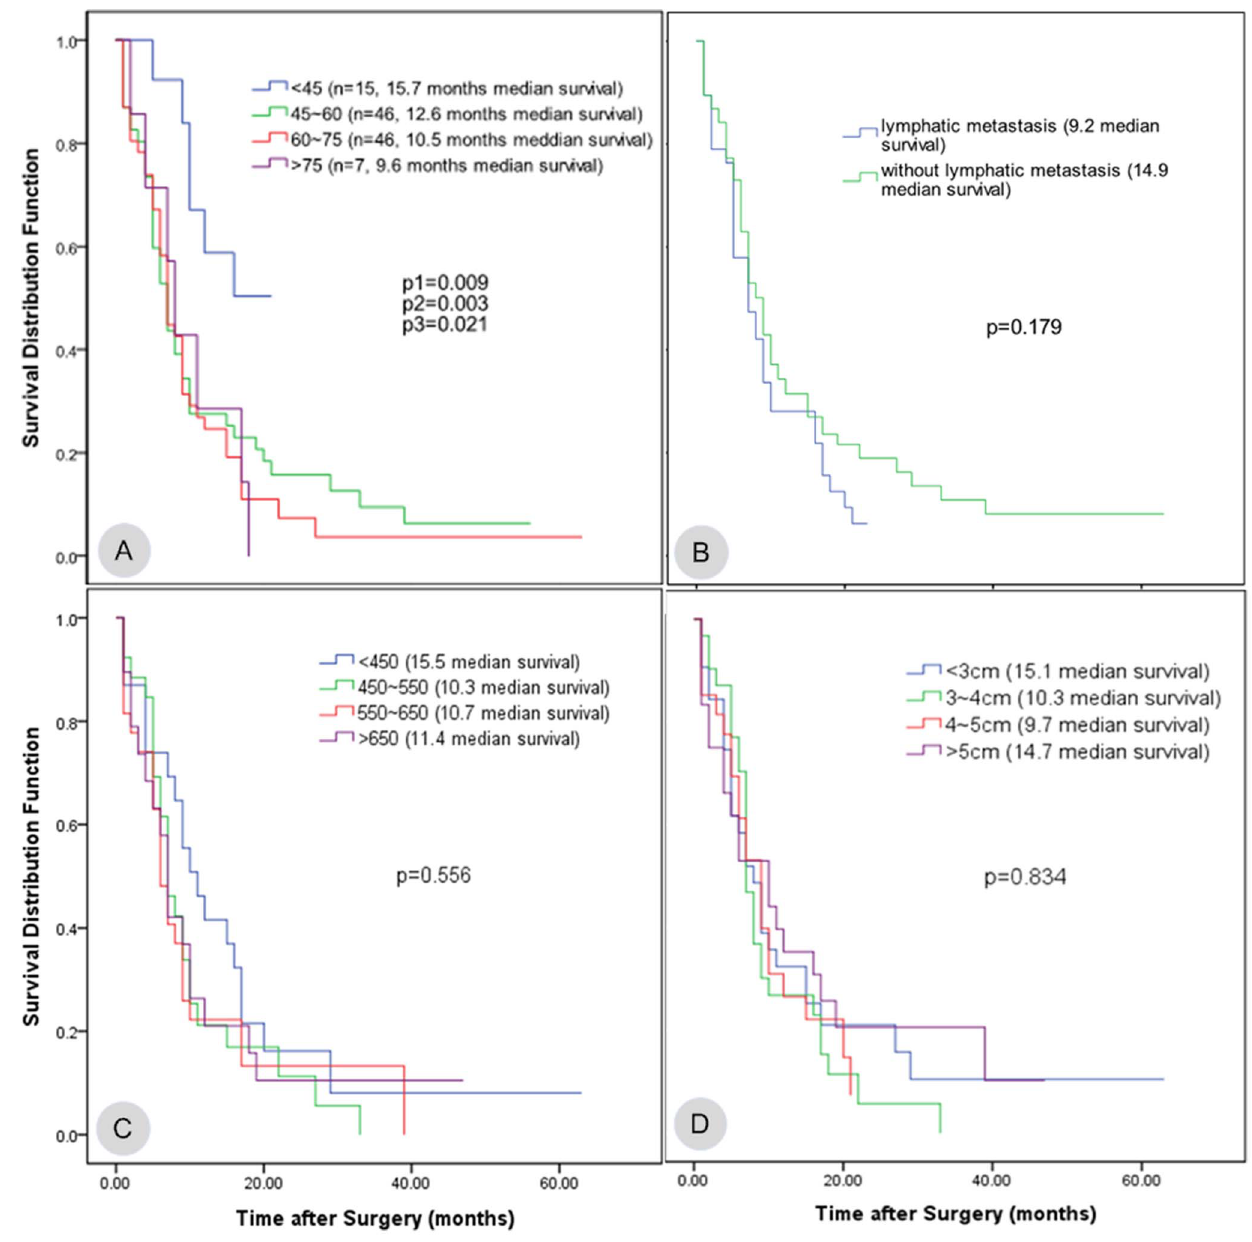
Figure 2. The relationship between the parameters of patients treated with combined vascular resection and reconstruction and the postoperative survival time. A. The patients were divided into four groups according to age: , 45 years old, 45 to 60 years old, 60 to 75 years old, and . 75 years old. The comparison between the first group and the rest of the groups yielded p , 0.05. B. The patients were divided into two groups according to the presence or absence of lymph node metastasis. The median survival time of these two groups was 9.2 and 14.9 months, respectively (p=0.179). C. The patients were divided into four groups according to the operative time: less than 450 min, 450 to 550 min, 550 to 650 min, and more than 650 min. The median survival time and the 95% confidence intervals were 15.5 (8.2, 22.8), 10.3 (6.8, 13.7), 10.7 (6.0, 15.4), and 11.4 (5.5, 17.3), respectively, with p=0.556. D. The patients were divided into four groups according to tumor diameter: less than 3 cm, 3 to 4 cm, 4 to 5 cm, and greater than 5 cm. The median survival times and 95% confidence intervals were 15.1 (8.2, 22.0), 10.3 (7.4, 13.2), 9.7 (7.0, 12.5), and 14.7 (8.3, 21.2), respectively, with p=0.834.